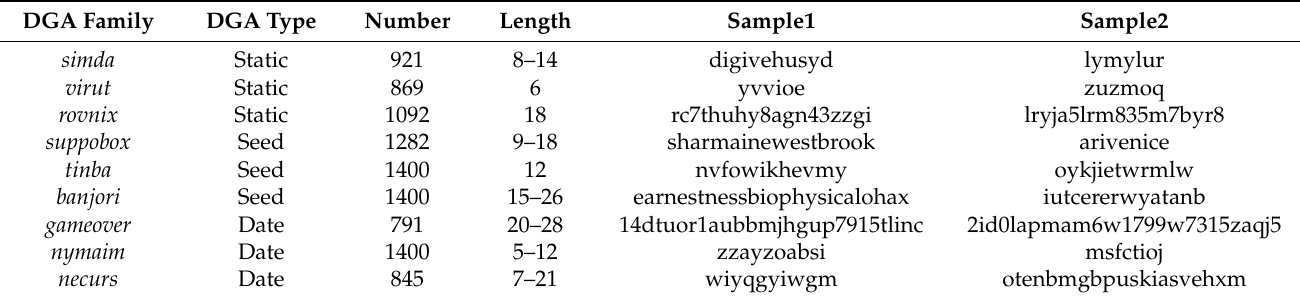
Table 2. Characteristics of DGA families.